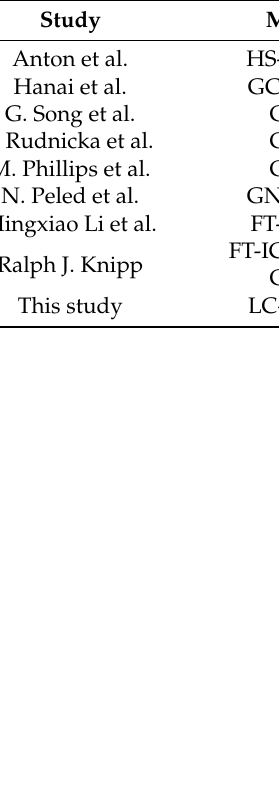
Table 3. Previous studies on VOC biomarkers in patients with lung